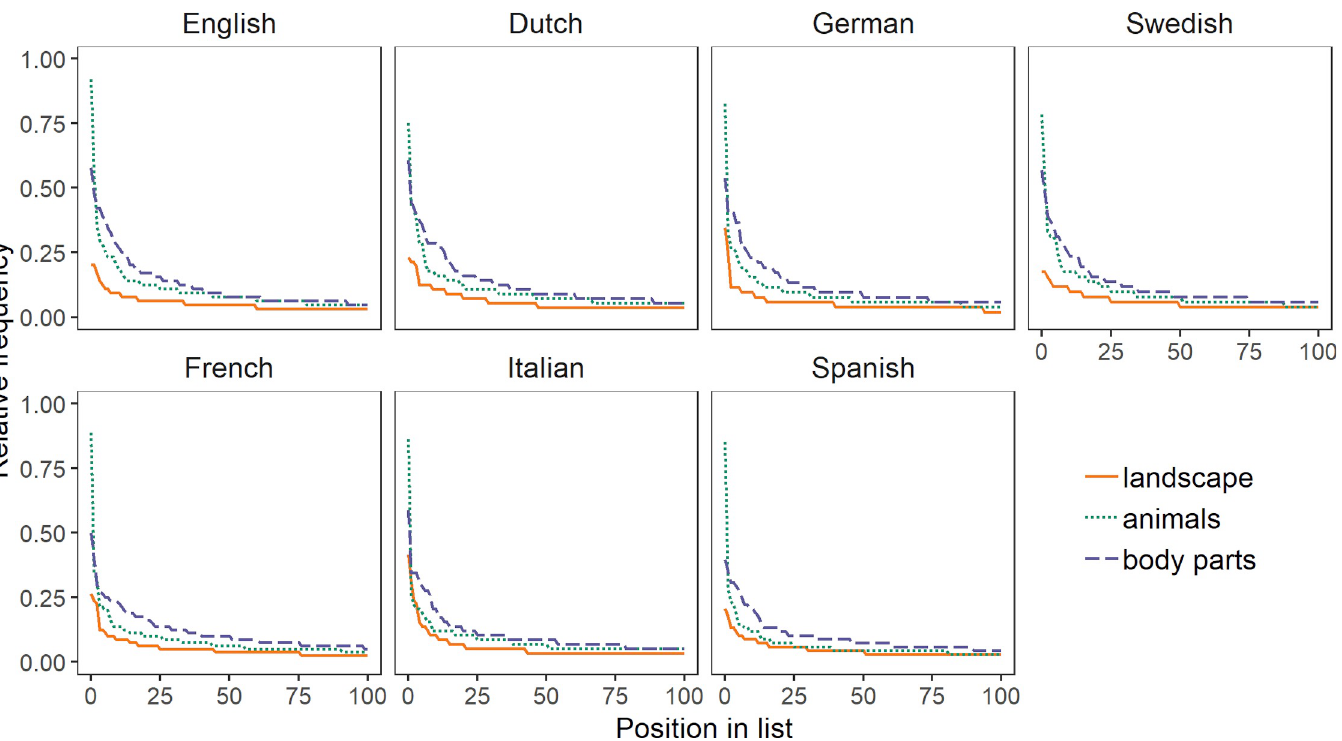
Fig 3. Frequency distributions of co-occurrence pairs for “landscape”, “animals”, and “body parts” in seven languages. The x-axis represents the 100 most frequent co-occurrence pairs ordered from most to least frequent; the y-axis represents frequency relative to the number of participants. In all languages, “landscape” had the fewest common co-occurrence